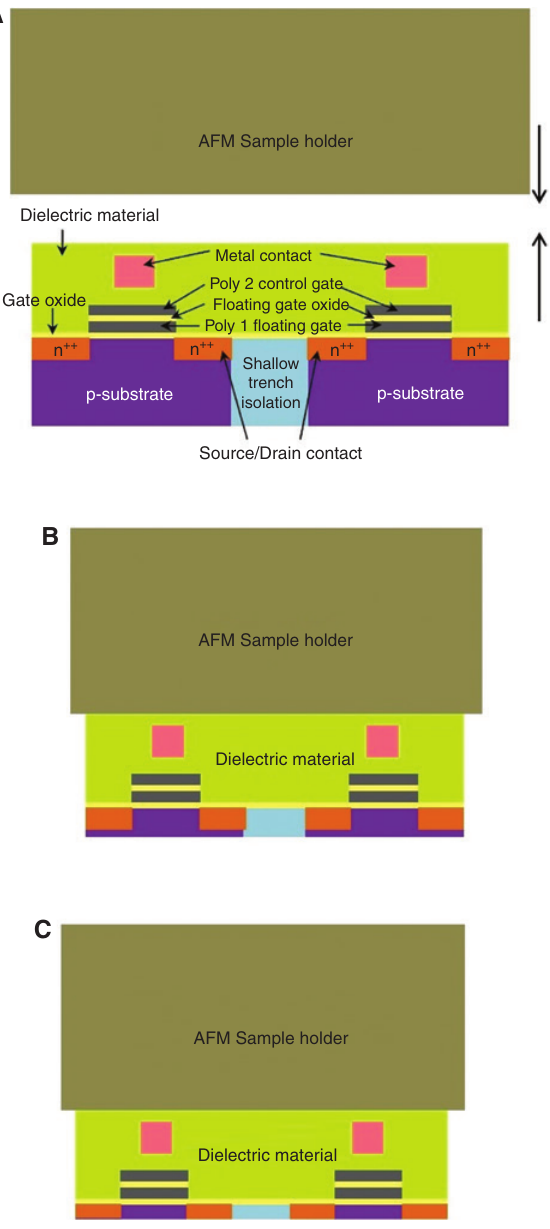
Figure 13: Schematic diagram of the sample preparation process performed on the NVM devices. (A) Sample is glued to the AFM sample holder using silver epoxy, making it ready for backside deprocessing. (B) Rough polishing on the backside of sample to remove the bulk silicon substrate until a thickness of 0.5 μ m.